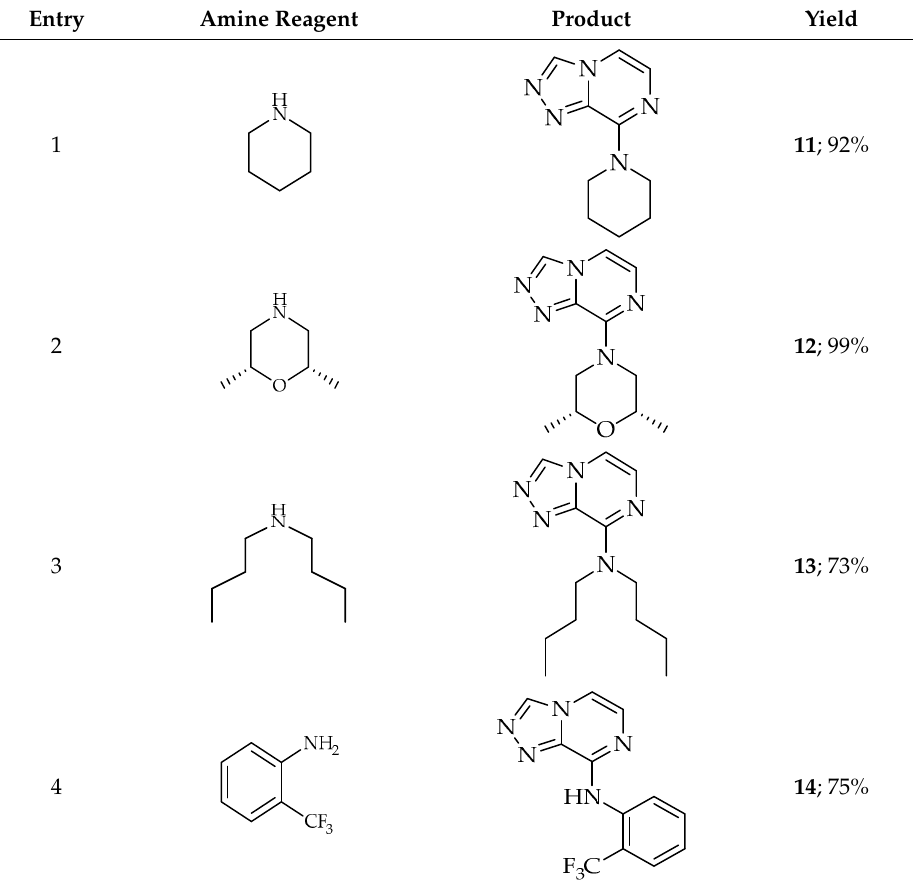
Molecules 2018 , 23 , x